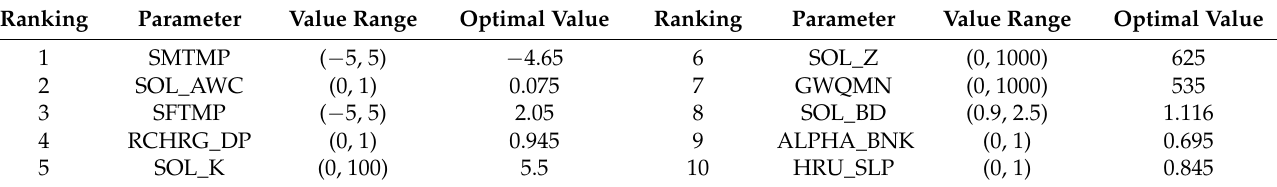
Table 4. Initial ranges and final optimal values of critical